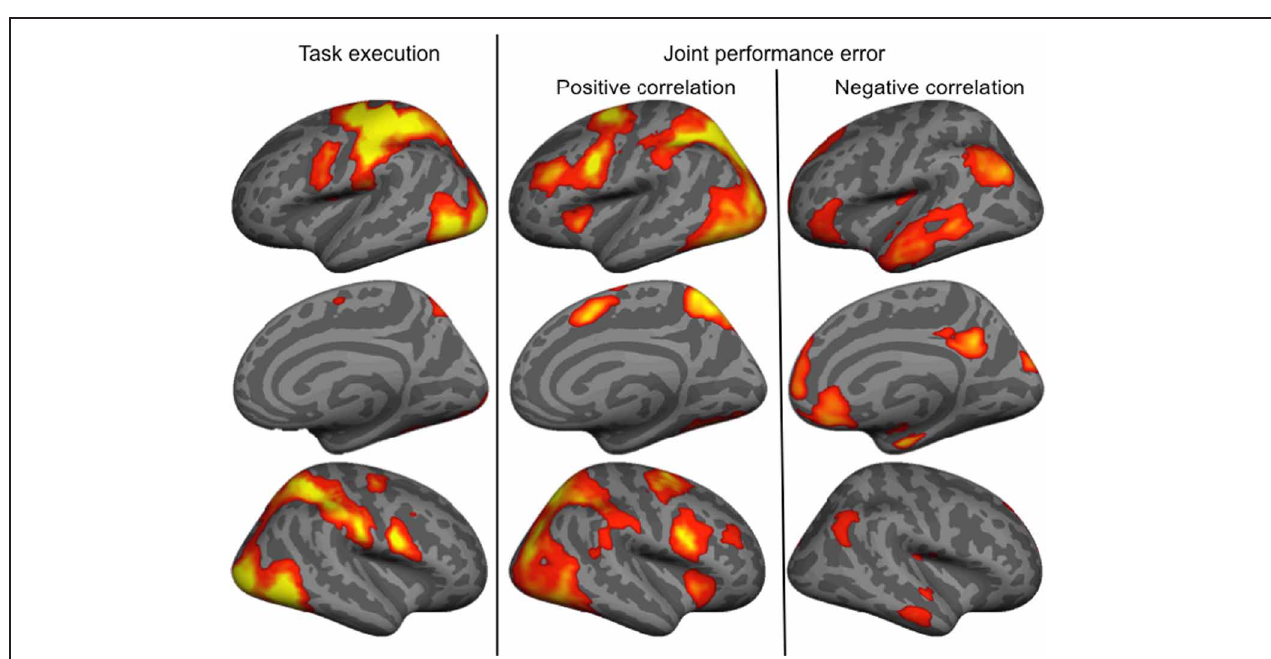
FIGURE 4 | Brain activity associated with the main effect of Task execution, and positively and negatively correlated with the joint performance